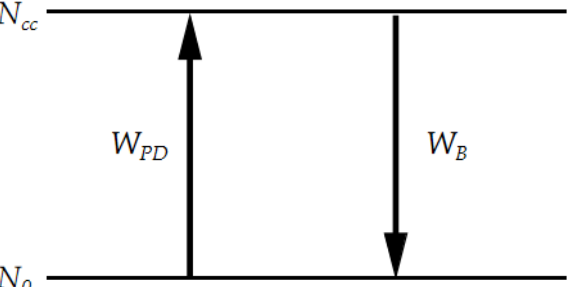
Figure 2. The process of photodarkening and bleaching. 𝑁 0 is the density of the photodarkening precursor, 𝑁 𝑐𝑐 is the density of the CCs, 𝑊 𝑃𝐷 is the photodarkening rate, and 𝑊 𝐵 is the bleaching